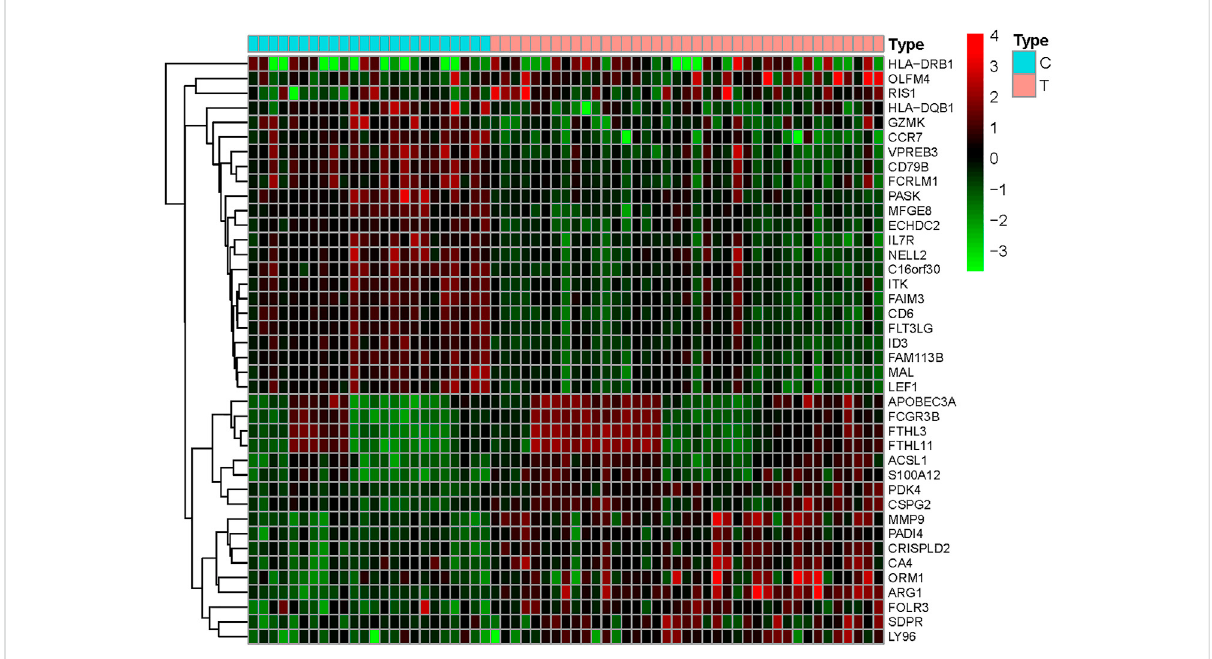
FIGURE 3 Gene heat map. Upregulated genes are indicated in red (logFC > 0) in the genome, downregulated genes are indicated in green (logFC < 0) in the genome, and black represents genes that do not have signi fi cant differences. The fi rst 24 samples came from the control group, and the last 39 samples came from the stroke